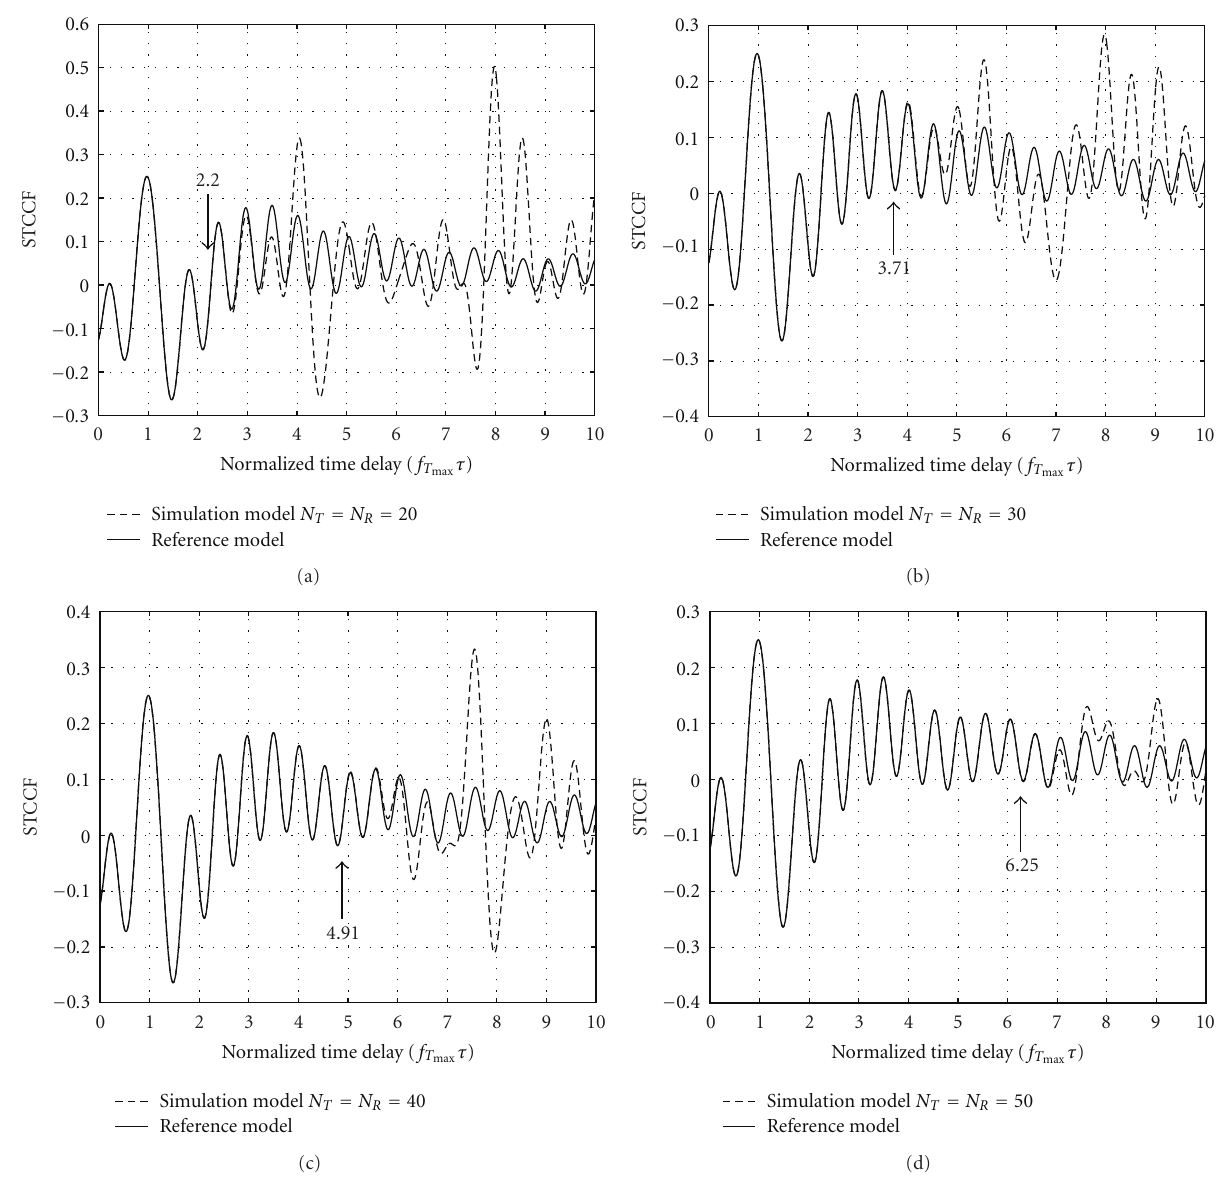
pq δ lm λ and N N T = R = 20, 30, 40, 50. R = 1 T =